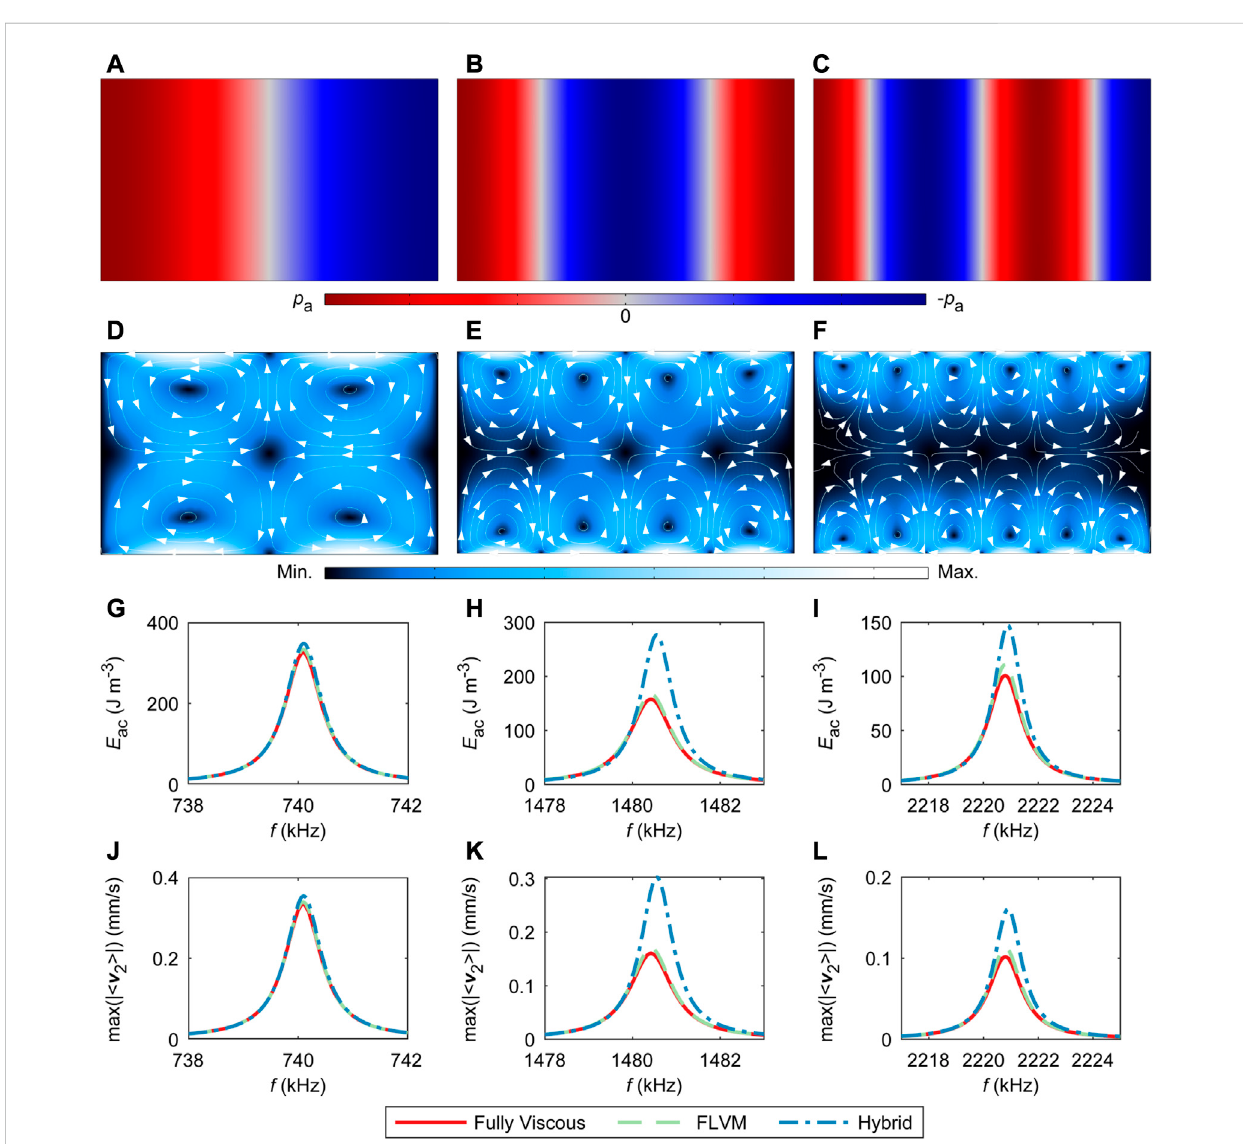
FIGURE 4 Different modeling approaches validated with a rectangular channel without the presence of a sharp edge. We compare the performance of the Fully Viscous model according to [15], the FLVM model from [22], and the Hybrid model outlined in Figure 2 that combines the two former approaches. Thecomparisonismadeforthe fi rstthreeresonancemodesinwateralongthechannelwidth a =1 mm,with b =200 μ m;mode1isshownin (A) , (D) , (G) , and (J) ; mode 2 in (B) , (E) , (H) , and (K) ; and mode 3 in (C) , (F) , (I) , and (L) . The fi rst row shows representative acoustic pressure fi elds (FLVM), the second row shows representative Eulerian streaming velocity fi elds (FLVM) with streamlines and arrows revealing the direction of the velocity, the third rowshowstheaverageacousticenergydensity E ac ,andthefourthrowshowsthemaximalmagnitudeoftheEulerianstreamingvelocity| 〈 v 2 〉 |.Tosupport the build-up of the corresponding resonances, the excitation at x =± a /2 with v a = 1 mm s − 1 is imposed in the same direction (in phase) for modes 1 and 3 and in the opposing directions ( π phase shift) for mode